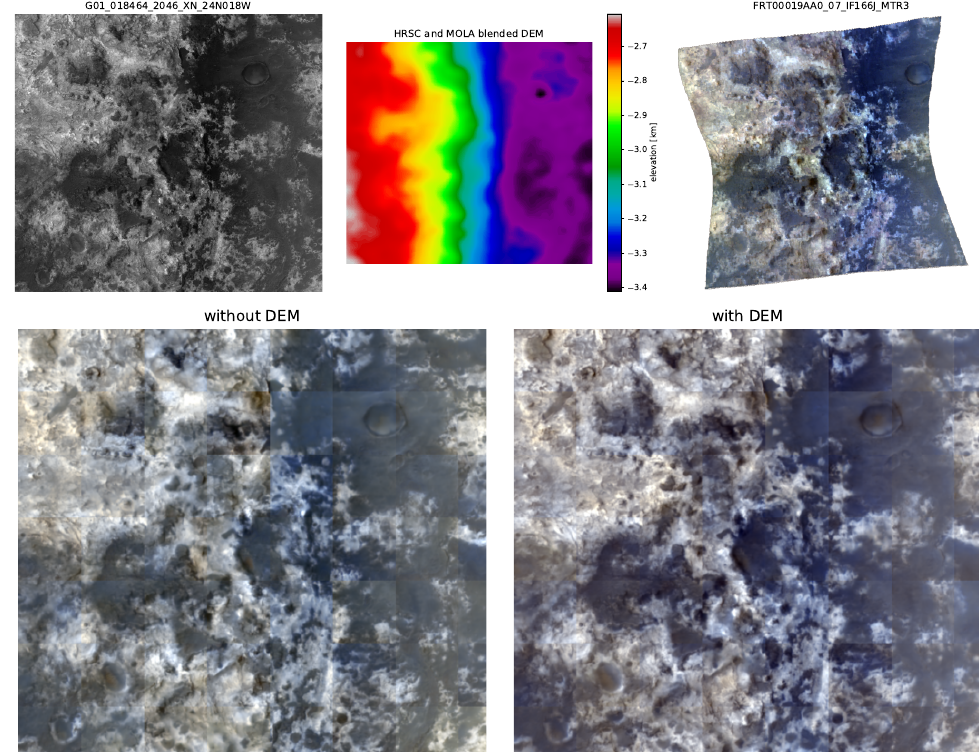
Figure 14. Mawrth Vallis’ CTX ( left ), DEM ( center ) and EVC CRISM ( right ) images from the validation set on top, and model predictions with ( right ) and without DEM ( left ) as input on the